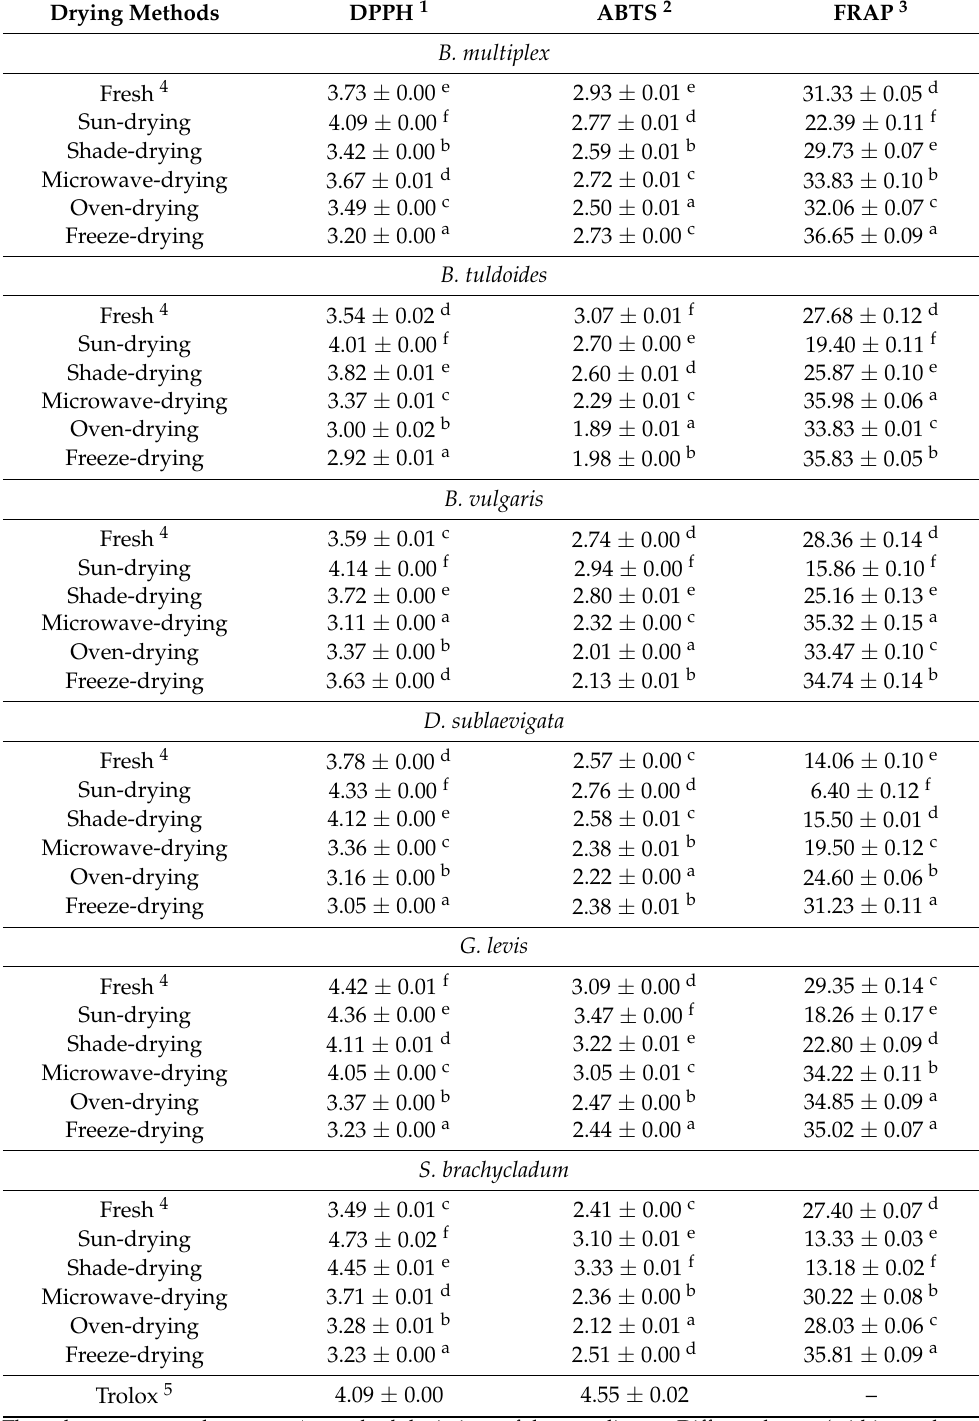
The values represent the means ± standard deviations of three replicates. Different letters (within a column) indicate significant differences (one-way ANOVA, Duncan’s multiple comparison test, p < 0.05). 1 DPPH